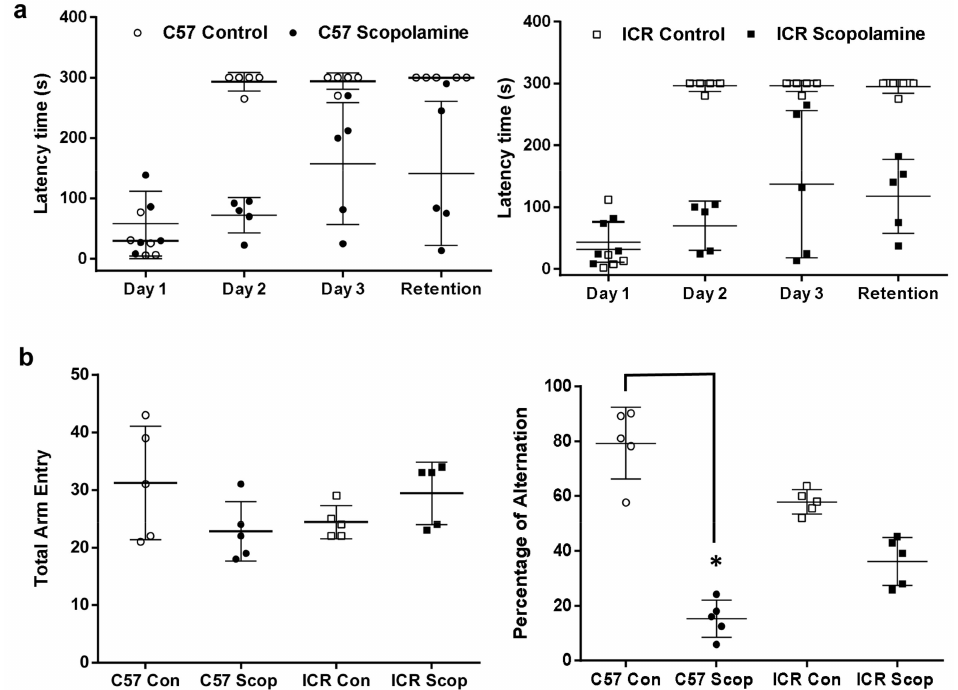
Figure 2. Spatial learning and memory analysis comparison of ICR and C57BL/6 strains in scopolamine-induced amnesic model: ( a ) Step-through passive avoidance test—latency variance of the 3-day acquisition and fourth day retention trial; ( b ) Spontaneous alternation performance (Y-maze test). Data are expressed as mean ± SD ( n = 5). The PAT data was analyzed using two-way ANOVA—Tukey’s multiple comparison test, # p < 0.05, within the same strains when the control and scopolamine treated groups are significant; Y-Maze data was analyzed using one-way